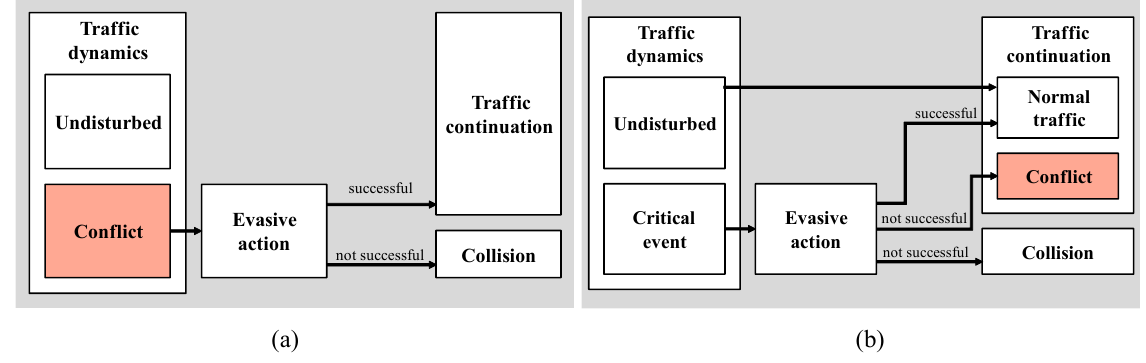
Figure 1 Two models of relation between traffic conflicts and crashes — adopted from Güttinger (1982) : (a) conflict precedes a collision; (b) conflict is mutually exclusive with a